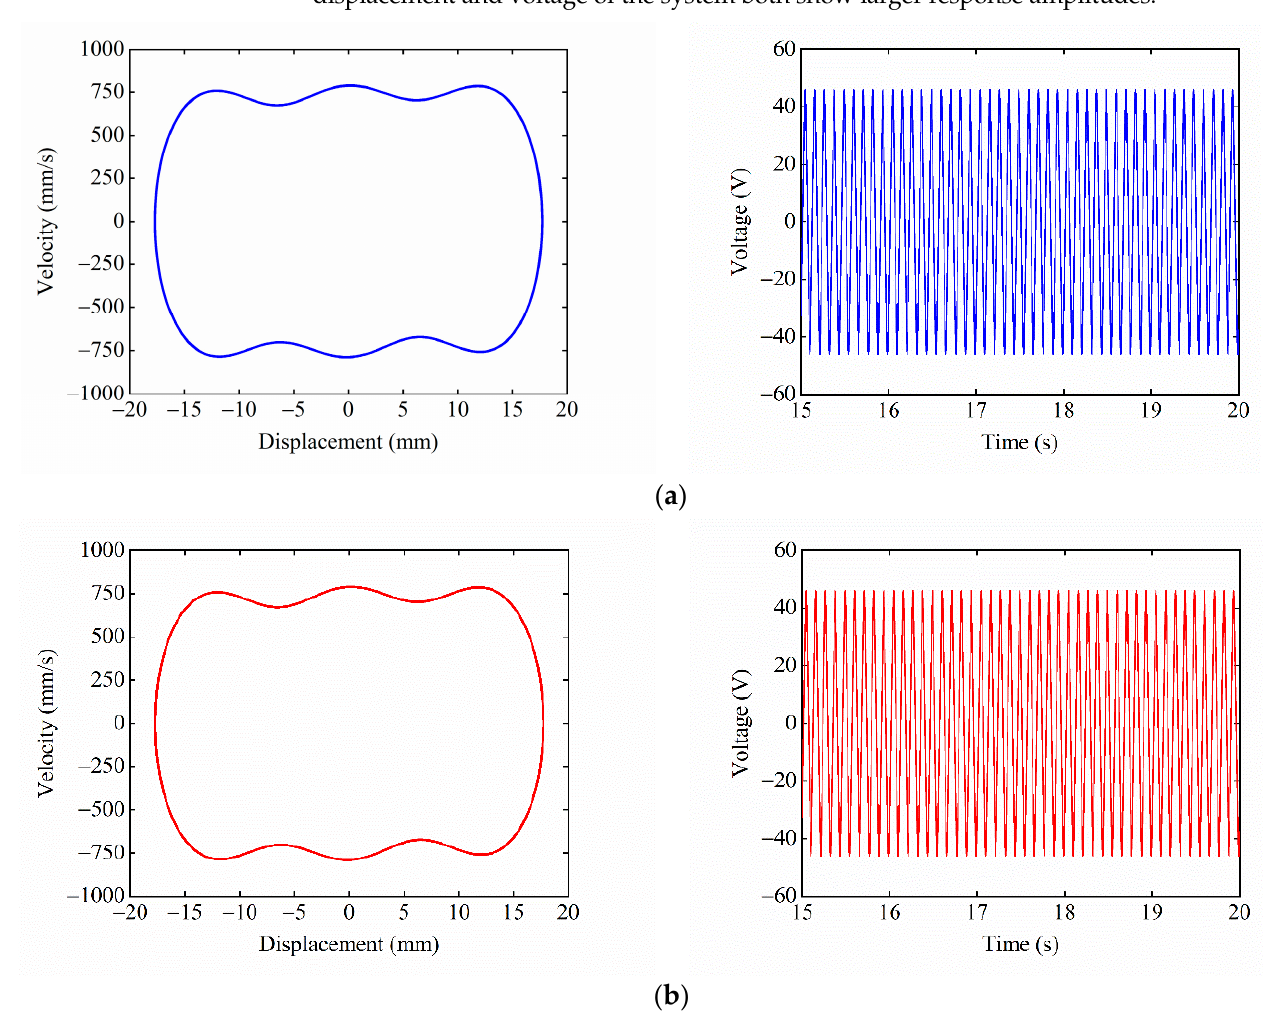
: ( a ) starting po- 𝛥𝛥𝑈𝑈 1 = 𝛥𝛥𝑈𝑈 2